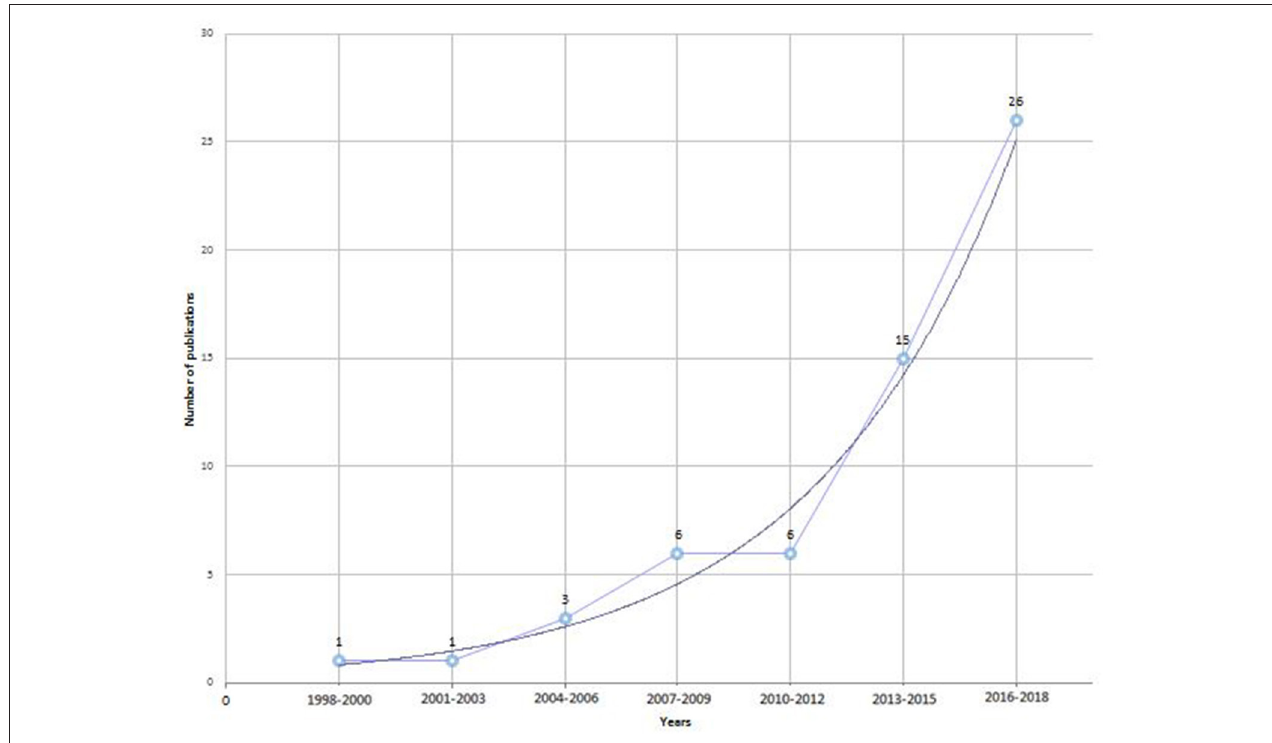
FIGURE 2 | Diagram of the studies retrived for the review: number of publications across